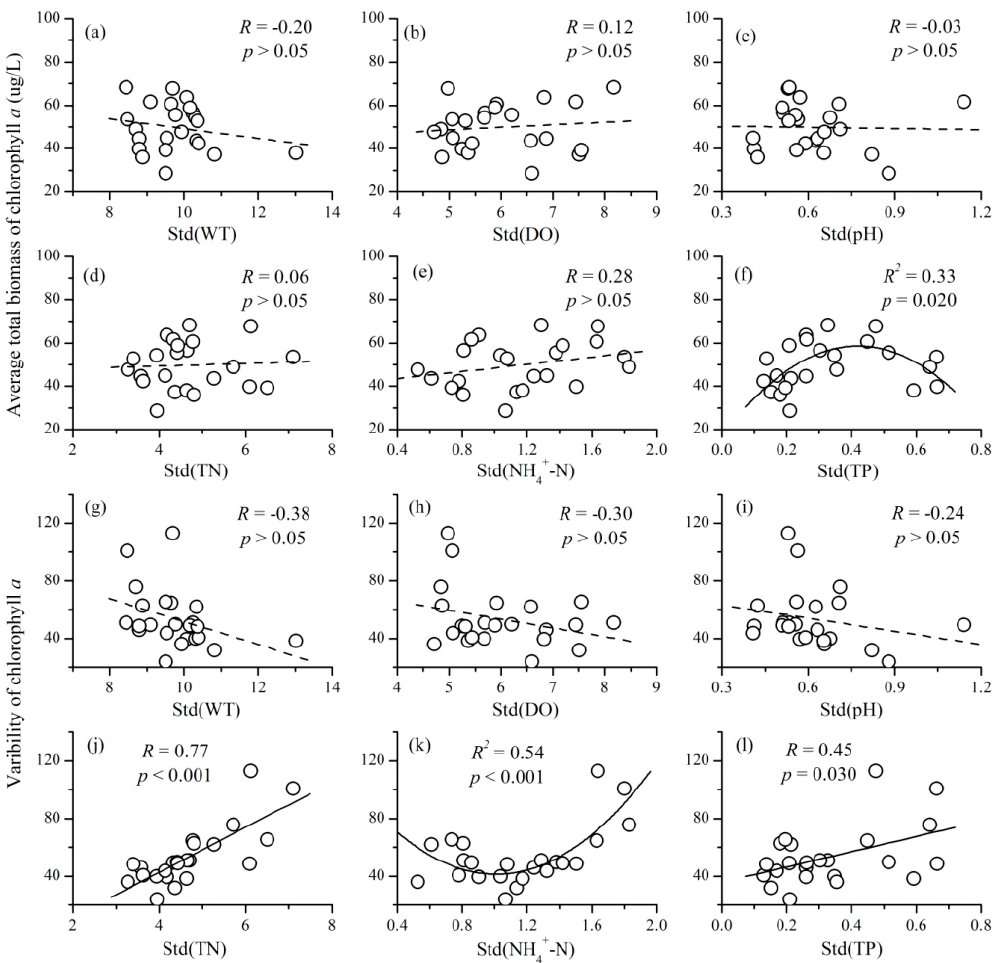
Figure 8. The relationships between the variability of ( a ) water temperature (WT); ( b ) dissolved oxygen (DO); ( c ) pH; ( d ) total nitrogen (TN); ( e ) ammonia nitrogen (NH 4+ -N); ( f ) total phosphorus (TP)